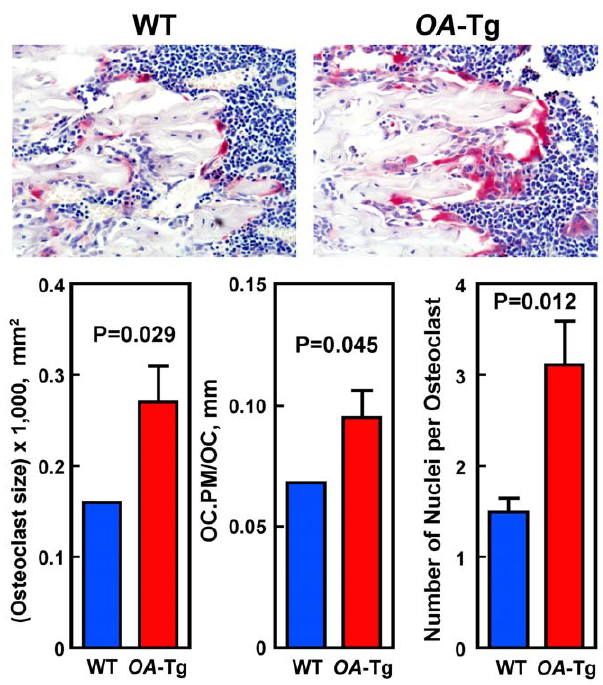
Figure 7. Effects of targeted overexpression of OA in osteo- clastic cells on the size and number of nuclei of osteoclasts in vivo . Top panel of Fig. 7 shows photomicrographs of the TRAP- expressing osteoclasts (counter-stained with hematoxylin) on the trabecular bone surface at secondary spongiosa of a WT mouse and an OA -Tg mouse. Bottom panels show the quantitative differences in osteoclast size per osteoclast (left), osteoclast surface per osteoclast (OC.PM/OC, middle), and number of nuclei per osteoclast (right) between six OA -Tg mice and four WT littermates. Results are shown as mean 6 SEM.